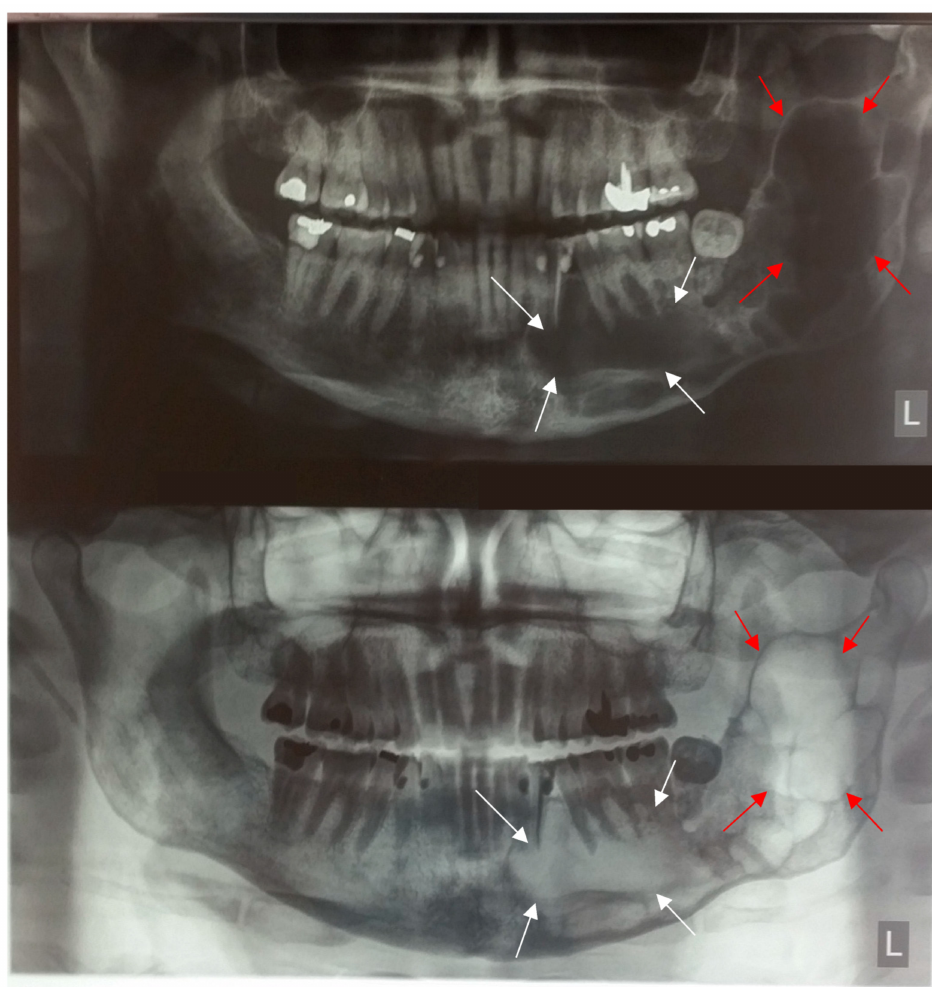
Figure 2. Orthopantomografy of a 47-year-old Gaucher disease patient. The white arrows indicate the typical “soap-bubble” appearance in premolar-molar regions. The red arrows indicate the mandibular